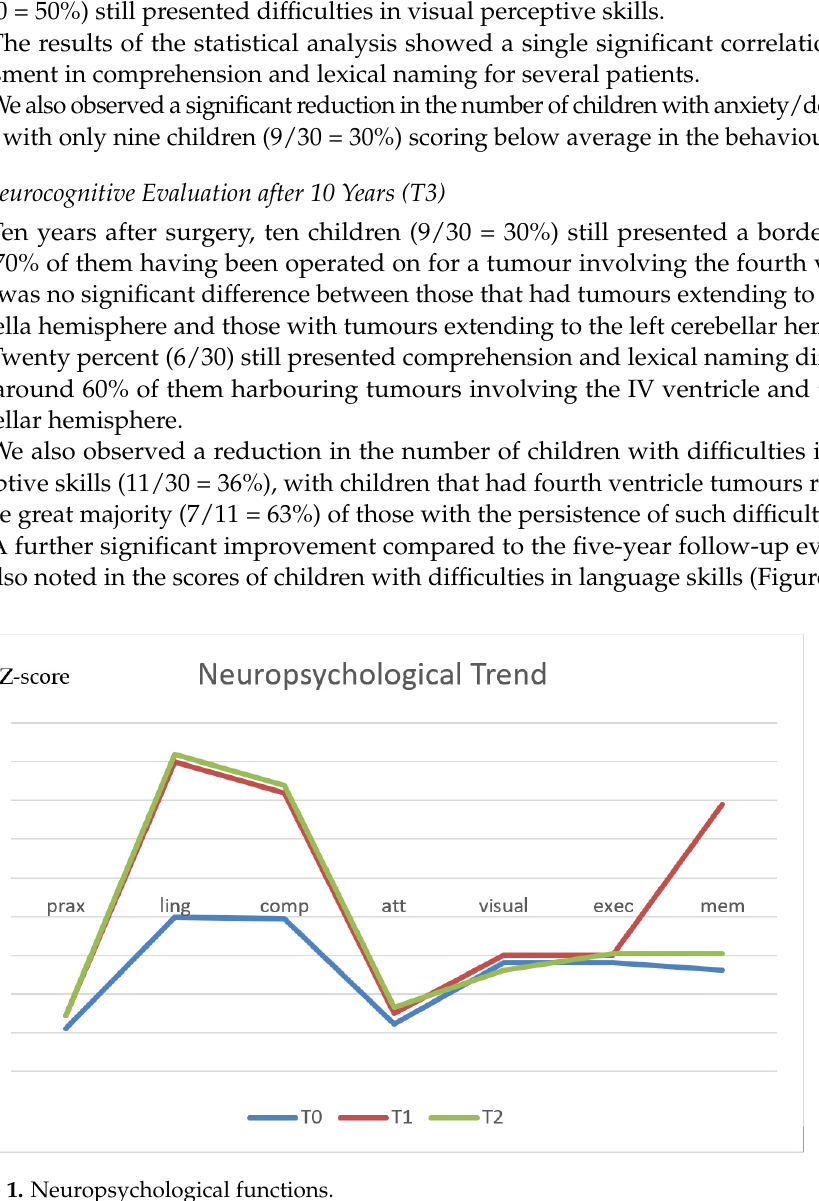
Figure 2. IQ trend. 3.5. Statistical Analyses Compared to the preoperative findings, we observed a significant improvement in the scores related to understanding skills at the evaluations performed after 1 year (p. 410*), which was confirmed after 5 years (p. 413*) and 10 years (p. 417*). A similar statistically significant improvement was documented regarding eloquence planning. The memory, visual perception and executive function test scores tended to progressively improve with successive follow-ups, but the related improvement did not reach statistical significance. Praxic and visuo-perceptive skills also very moderately improved over time. Finally, taking into account the behavioural evolution over time, though the percentage of affected children was moderately reduced in terms of the total score after 1 (p. ,445*), 5 (p. ,528**) and 10 years (p. ,535**), the anxiety/depression trait scores did improve significantly at the evaluations performed after 1 (p. 415*), 5 (p. 440*) and 10 years (p. ,455* ), compared to the pre-operative condition, with coincidental improvements in the externalising scale scores after 1 (p. 416*), 5 (p. 517**) and 10 years (p. 525**) (Table 2).